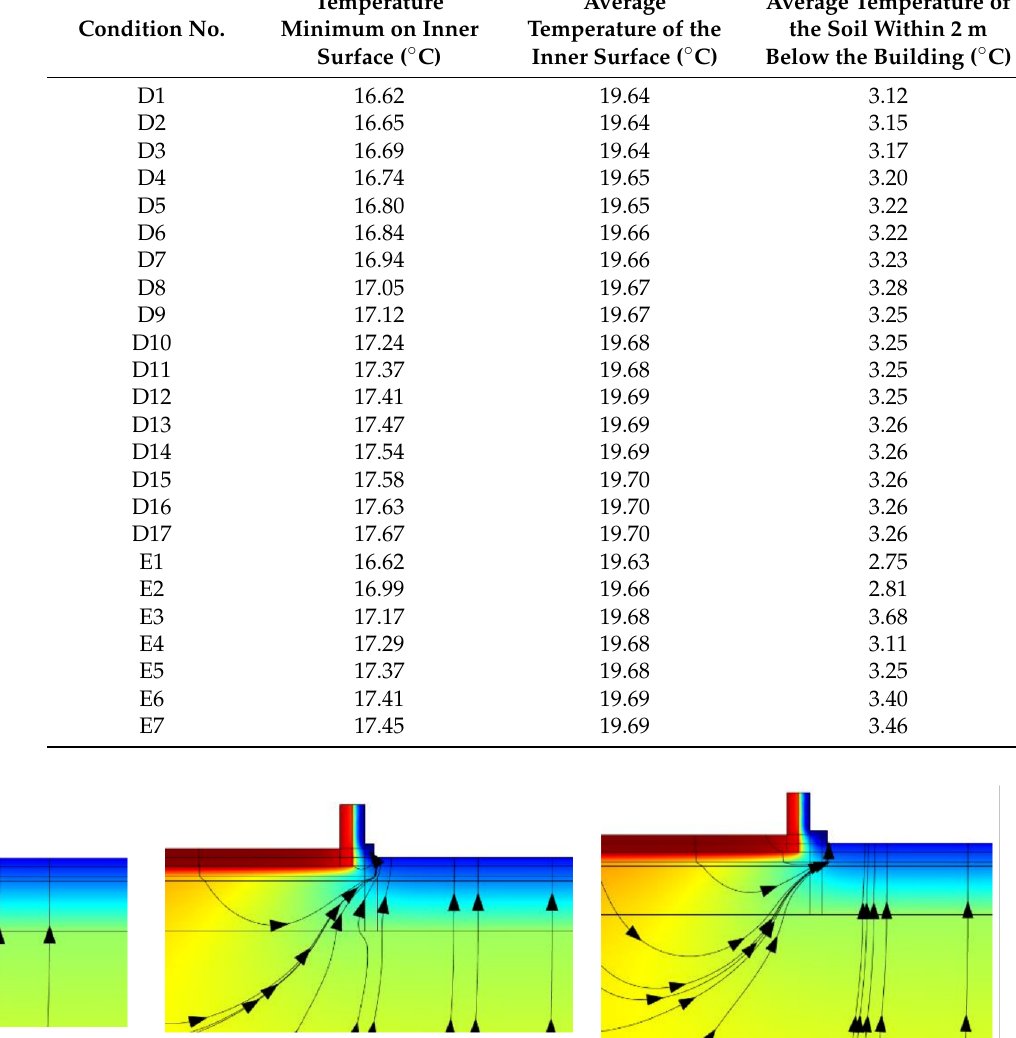
Table 7. Simulation results for Group D and E working conditions.